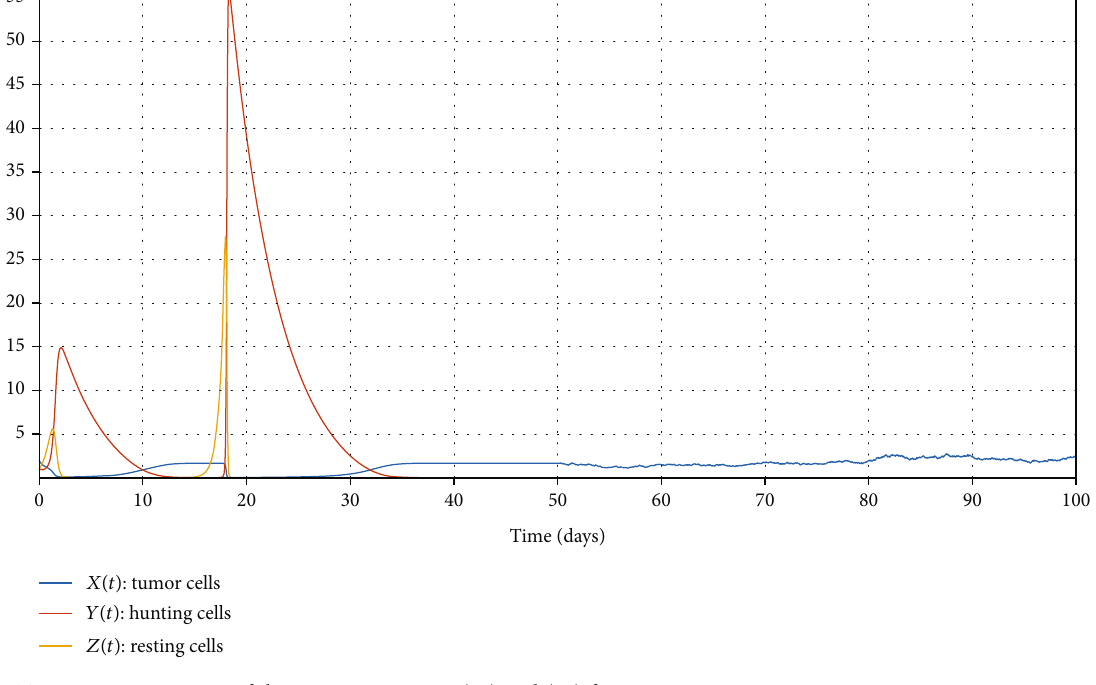
Figure 1: Time series trajectories of the piecewise systems (10) and (11) for c : 2 1 ,